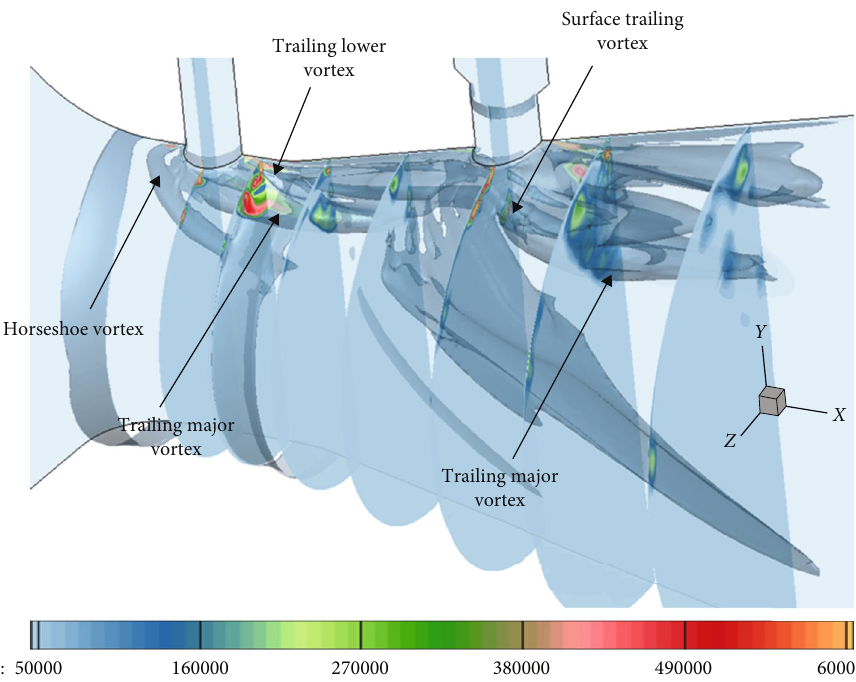
Figure 12: Vortex structure and vortex evolution, Liutex magnitude = 100,000 .